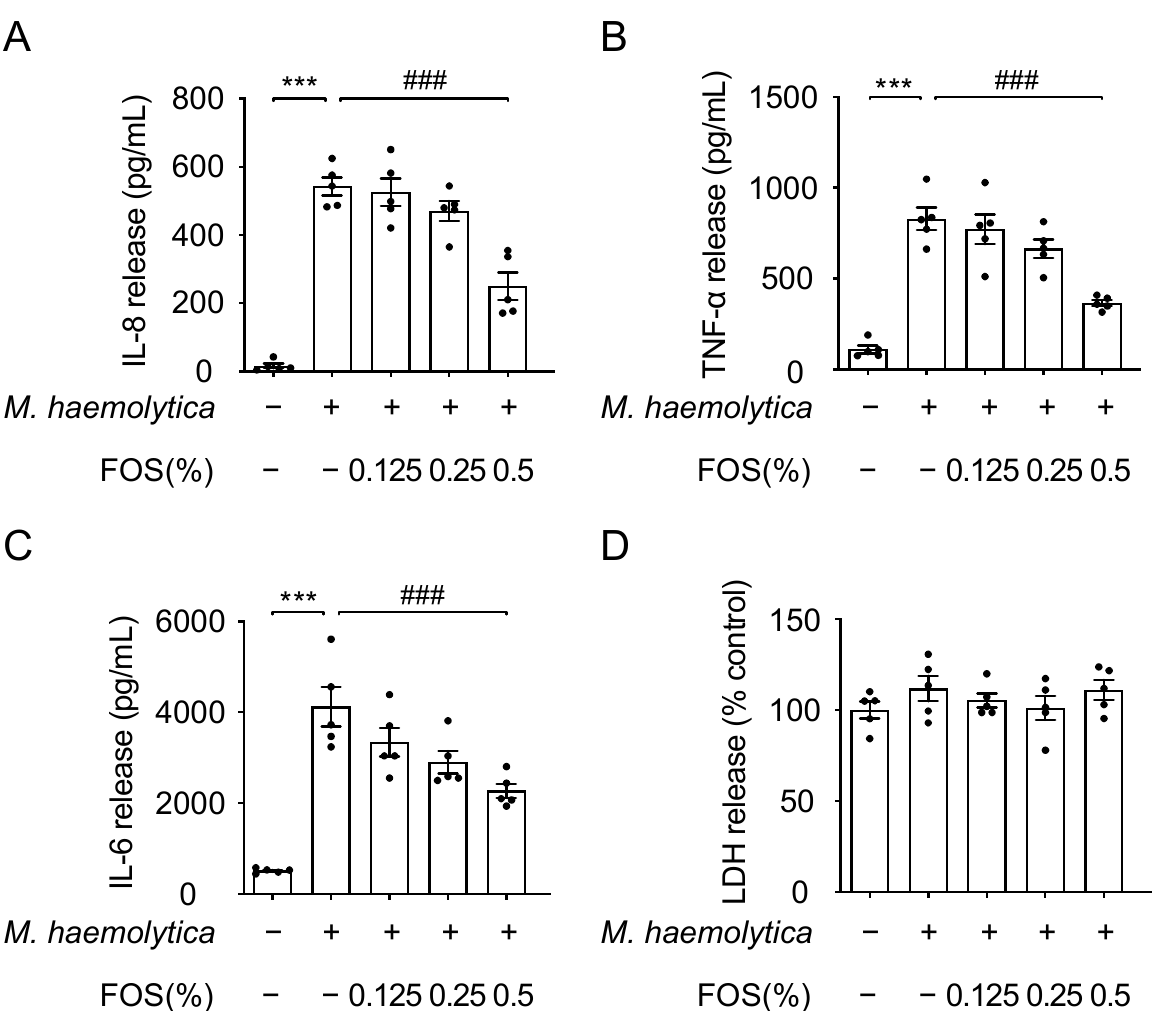
Figure 4. Effect of FOS on M. haemolytica -induced inflammation in PBECs. ( A ) IL-8, ( B ) TNF- α , ( C ) IL-6, and ( D ) LDH release were assessed in the supernatants of PBECs. Significantly different from control: *** p < 0.001. Significantly different from M. haemolytica : ### p < 0.001. Data are presented as means ± SEM. All data shown are representative of five independent experiments ( n = 5 donor calves, one donor calf per experiment). FOS, fructo-oligosaccharides; IL, interleukin; LDH, lactate dehydrogenase; TNF, tumor necrosis factor.